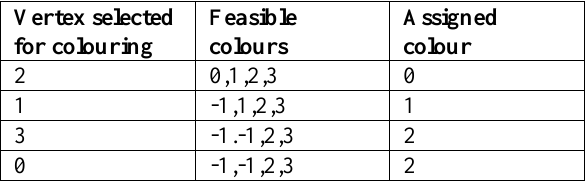
Table 6: Sequence of vertex selected for colouring based on decreasing order of the number of degrees of the graph of figure